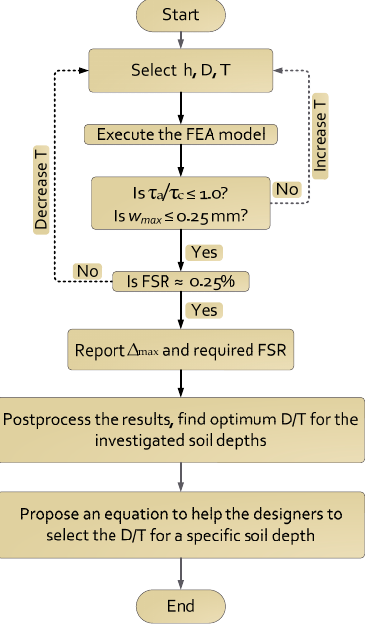
Figure 2. Flow chart to summarize the methodology of this study. 3. FEA Model and Construction Stages Figure 3 represents the FEA model’s geometry, boundary conditions, and mesh. The soil layers are the in situ soil, bedding, and fill soil. As the pipeline is symmetric about the pipe centerline, one-half of the pipe and soil layers were modeled. The pipeline was sim- ulated using 10 equal-length beam elements connected between 11 nodes. The 2D quad- rilateral elements of the modeled soil layers were defined below and above the pipeline